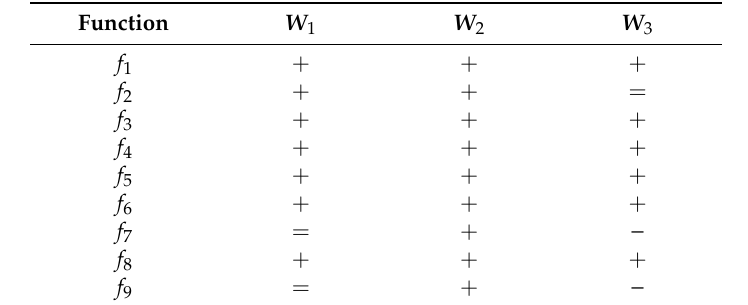
Table6. Wilcoxonsigned-ranktestappliedtotheoriginalandhybridalgorithmsaccuracymeasurements. The sign of W 1 denotes whether FSSN algorithm outperforms Fish School Search (FSS), the sign of W 2 denotes whether FSSGD outperforms FSS, W 3 sign denotes whether FSSN outperforms FSSGD. The equality sign indicates no significant di ff